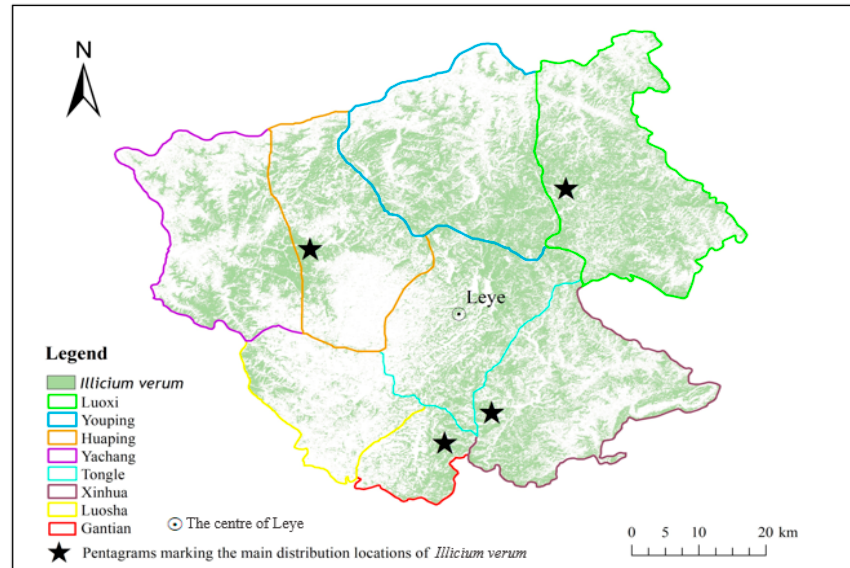
Figure 13. Distribution of Illicium verum in Leye County.